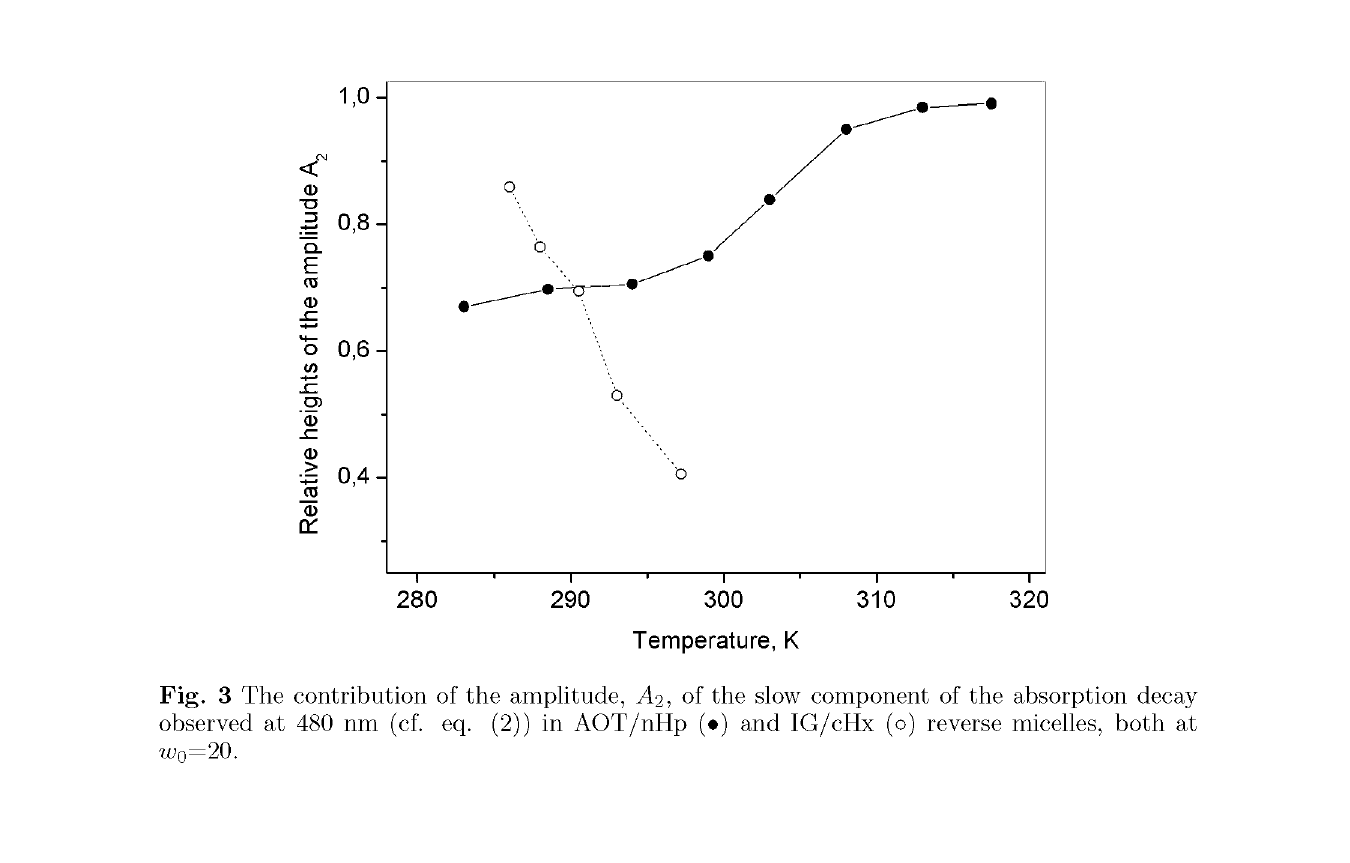
Fig. 3 The contribution of the amplitude, A2, of the slow component of the absorption decay observed at 480 nm (cf. eq. (2)) in aOT/nHp (.) and IG/cHx (o) reverse micelles, both at ~0